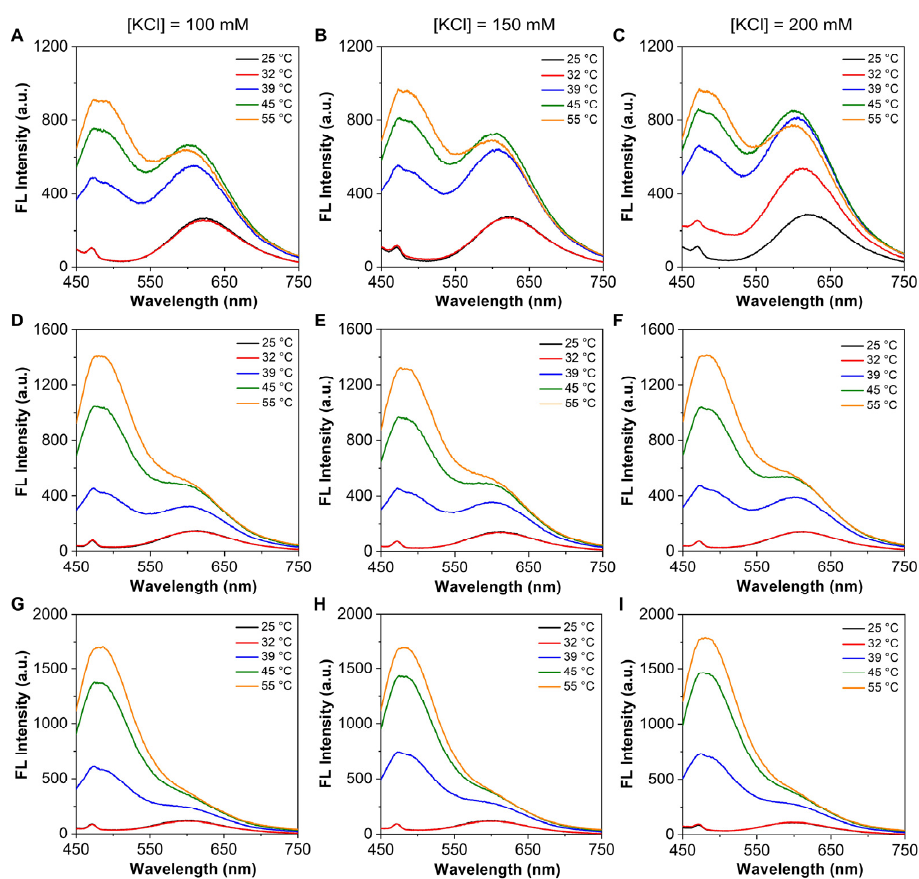
Figure 3. Temperature-dependent changes in the emission spectra of nanogels under different salting-out conditions. ( A – C ) Emission spectra of NG-1 (0.25 mg mL − 1 ) in ( A ) 100, ( B ) 150, and ( C ) 200 mM KCl solutions at different temperatures. ( D – F ) Emission spectra of NG-2 (0.25 mg mL − 1 ) in ( D ) 100, ( E ) 150, and ( F ) 200 mM KCl solutions at different temperatures. ( G – I ) Emission spectra of NG-3 (0.25 mg mL − 1 ) in ( G ) 100, ( H ) 150, and ( I ) 200 mM KCl solutions at different temperatures. Ex = 405